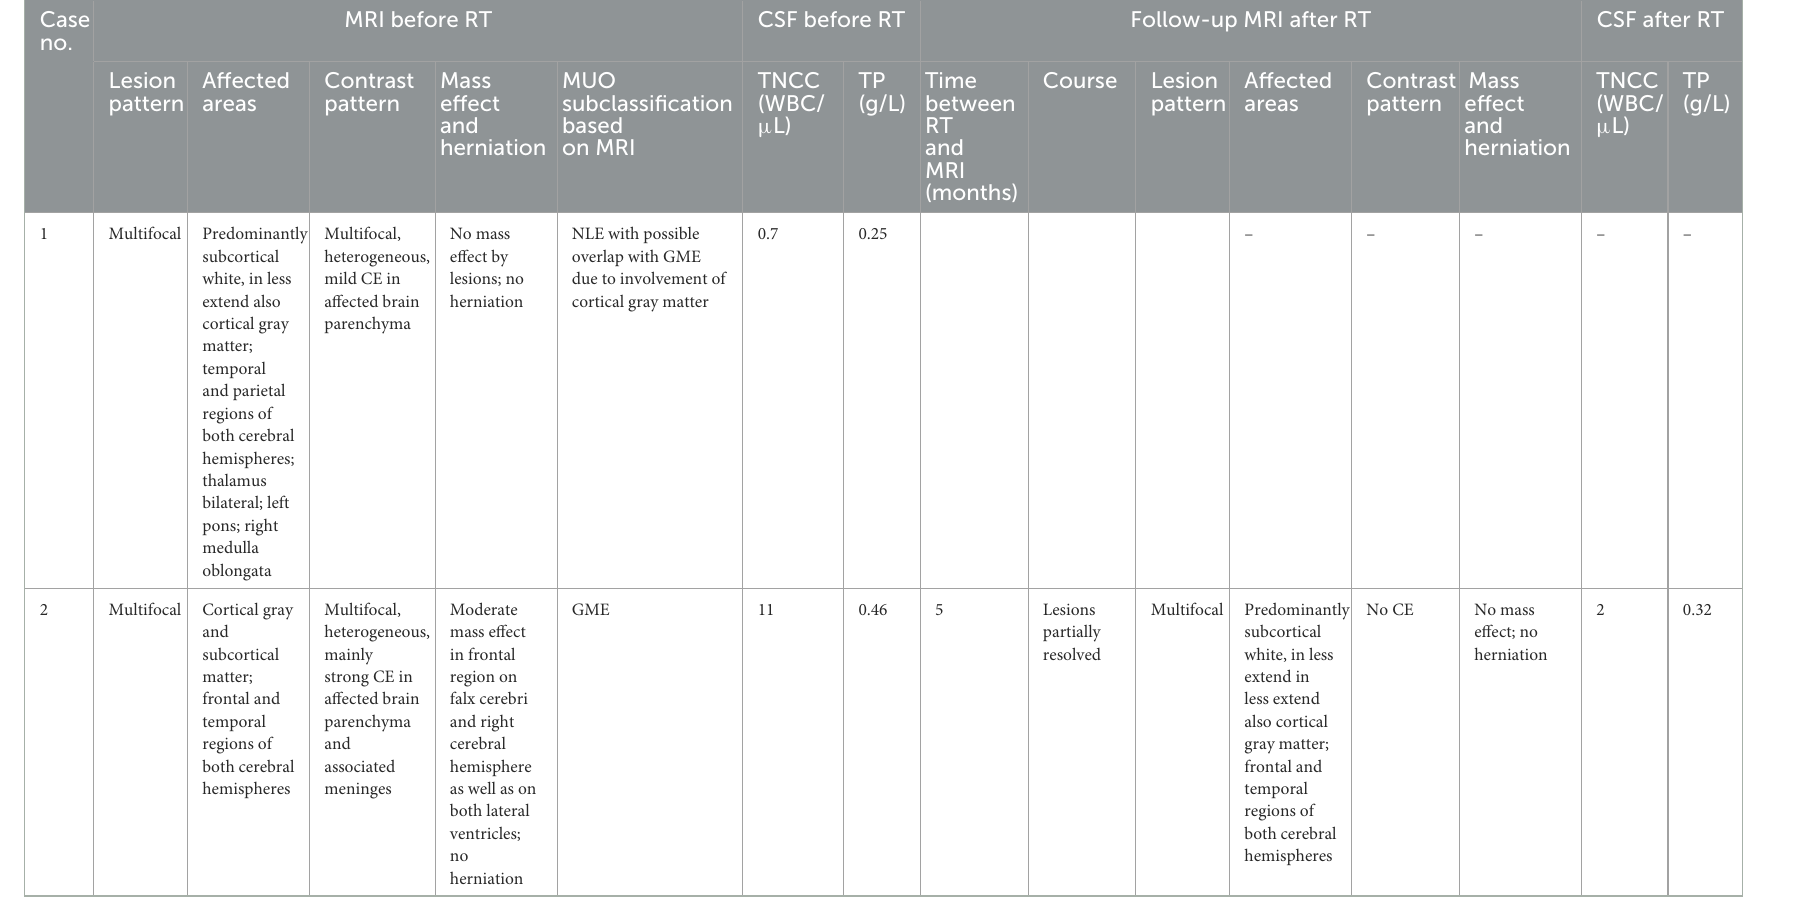
TABLE 2 MRI and CSF findings. Case